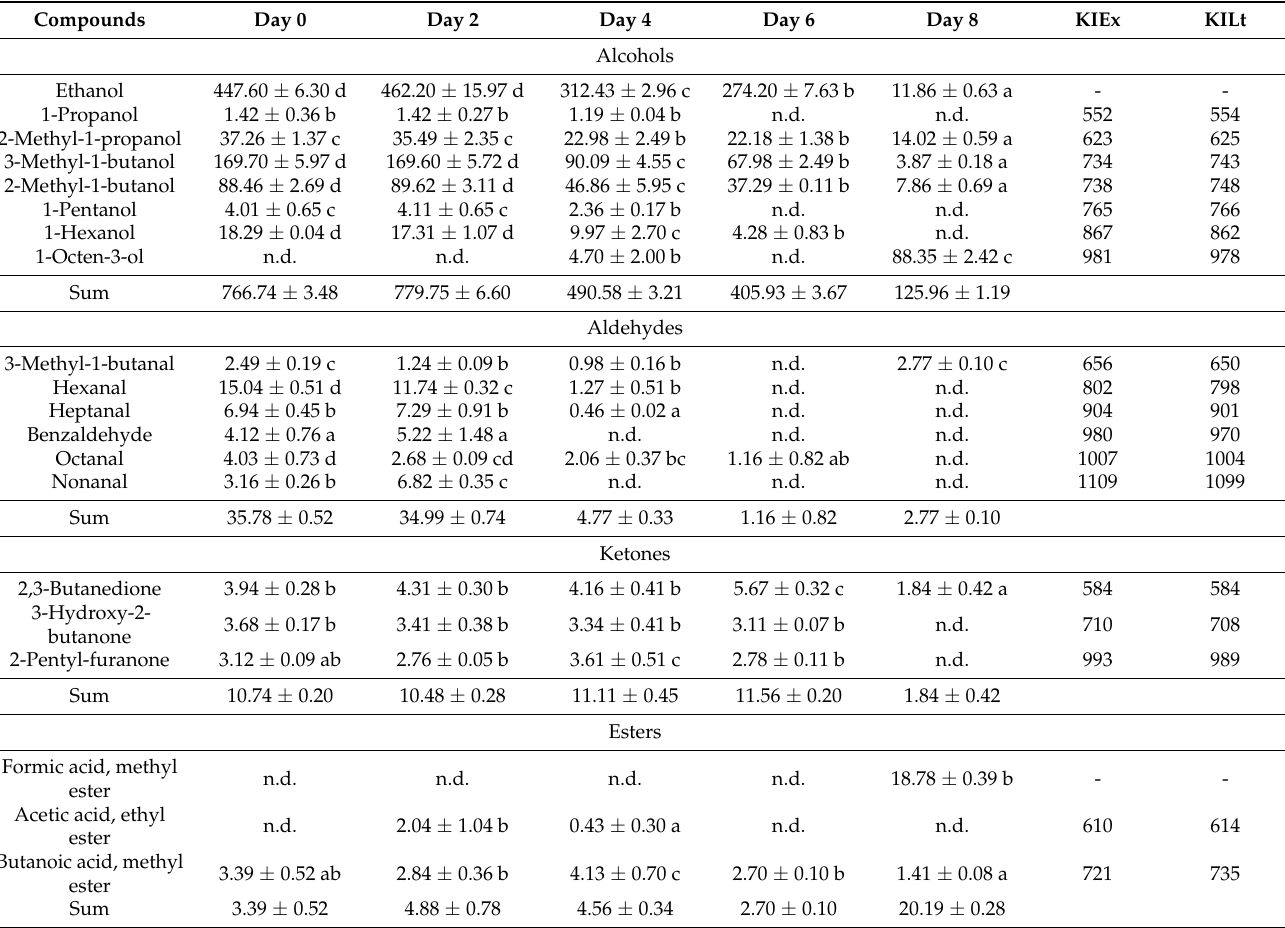
Table 3. Effect of storage time on evolution of volatile ( µ g/kg) in yeast leavened bread stored at 25 ◦ C.